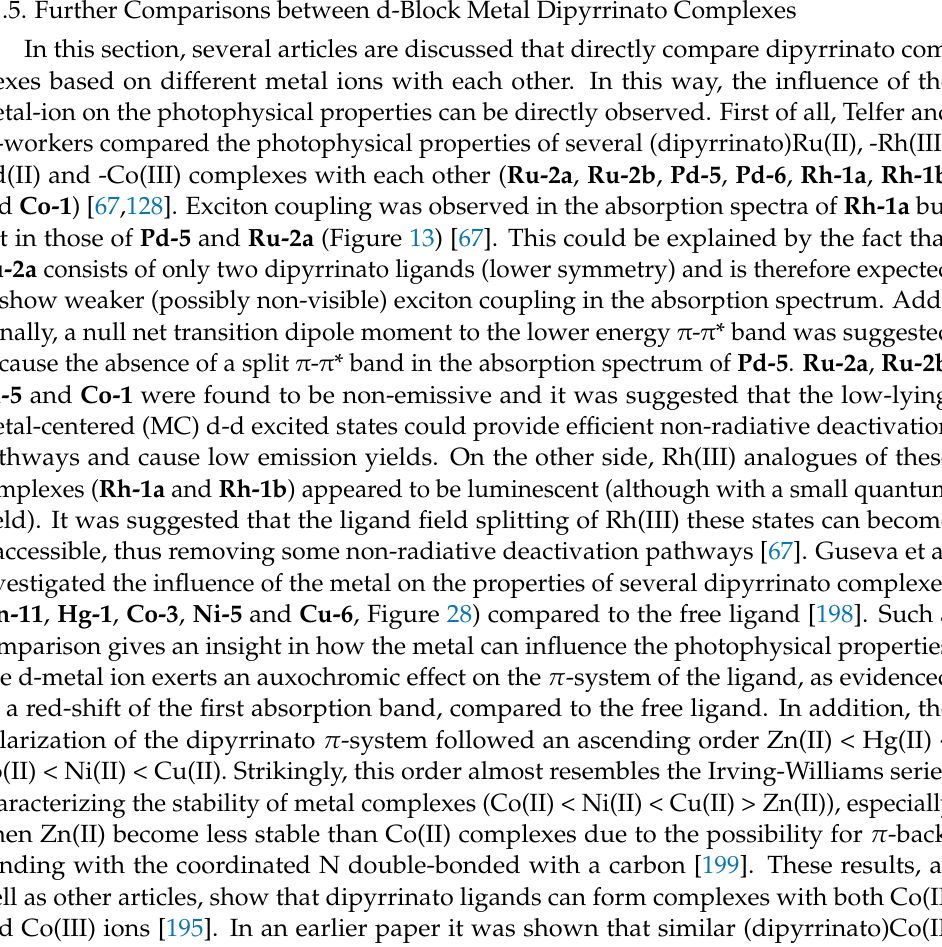
Figure 27. ( a ) View of the molecular structure of Ni-4 and ( b ) Cu-5 in the crystal. Hydrogen atoms have been omitted for clarity, thermal ellipsoids show 50% probability [197]. See the main text for more discussion on the properties of these compounds. (CCDC number: 1047912 ( a ) and 1047911 ( b ) [183]).